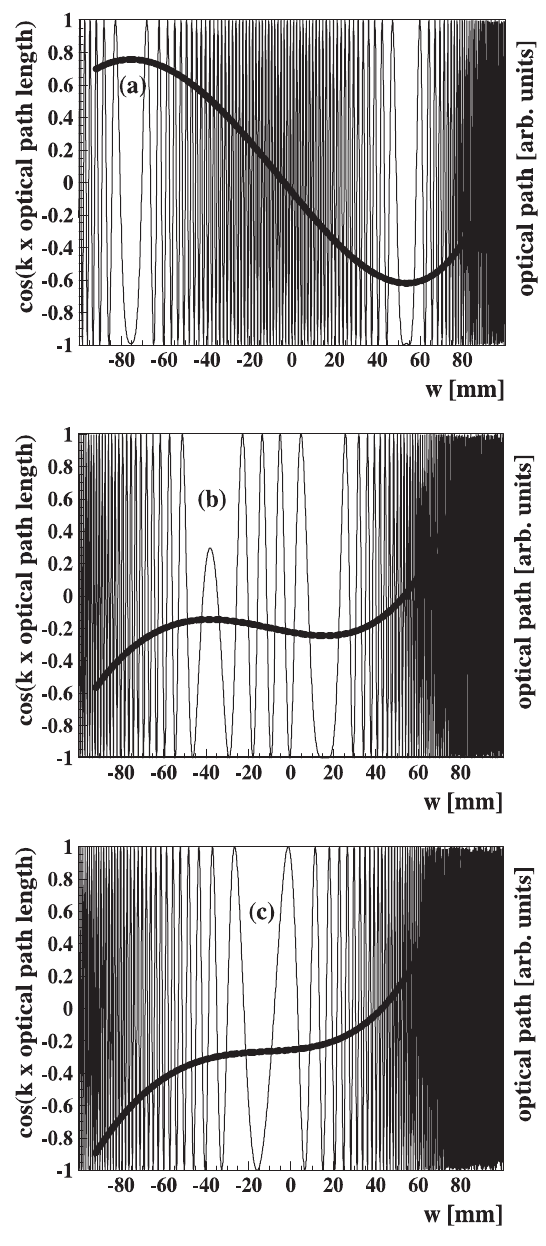
FIG. 4. (a) Paths of stationary phase are well separated. (b) Paths of stationary phase interfere. (c) There is no path of stationary phase but the contribution to the integral cannot be